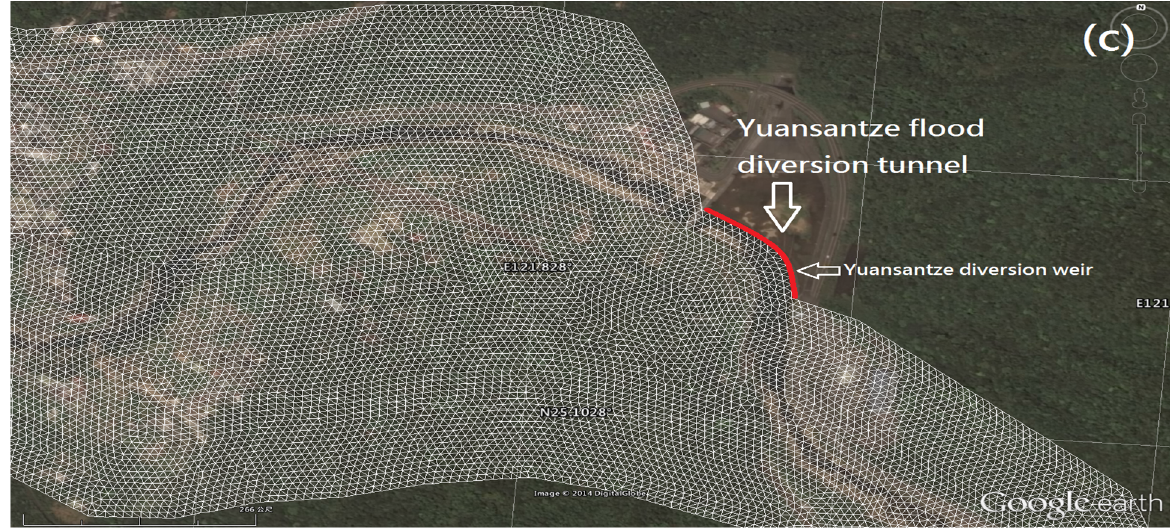
Figure 2. ( a ) Bathymetry and topography for the model domain; ( b ) unstructured grids